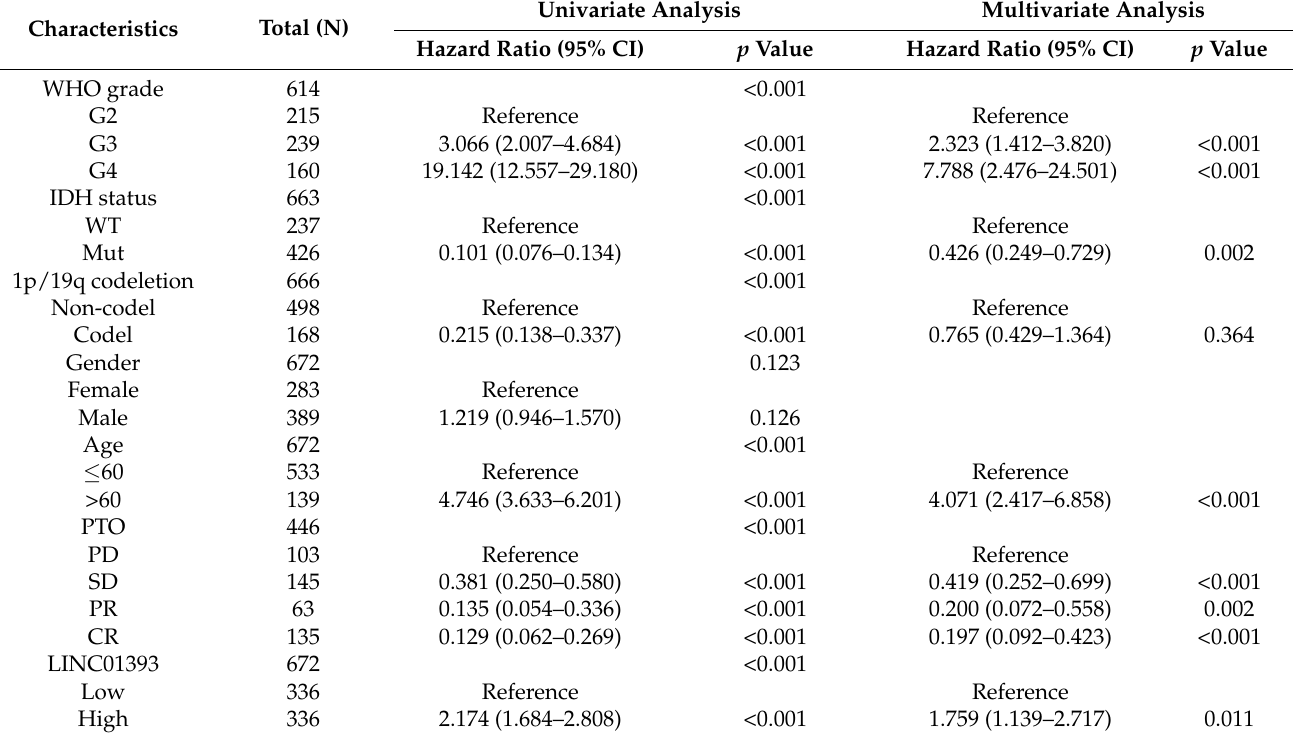
Table 1. Univariate and multivariate Cox regression analysis in the TCGA LGG-GBM